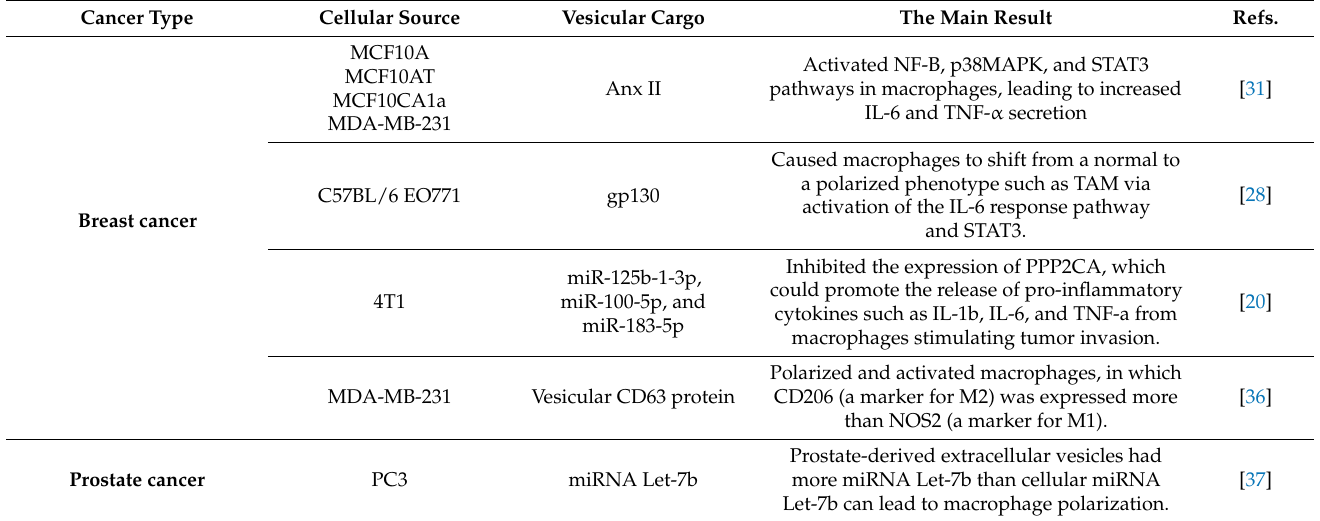
Table 1. Effect of tumor-derived extracellular vesicles on the macrophages in the tumor microenvi-